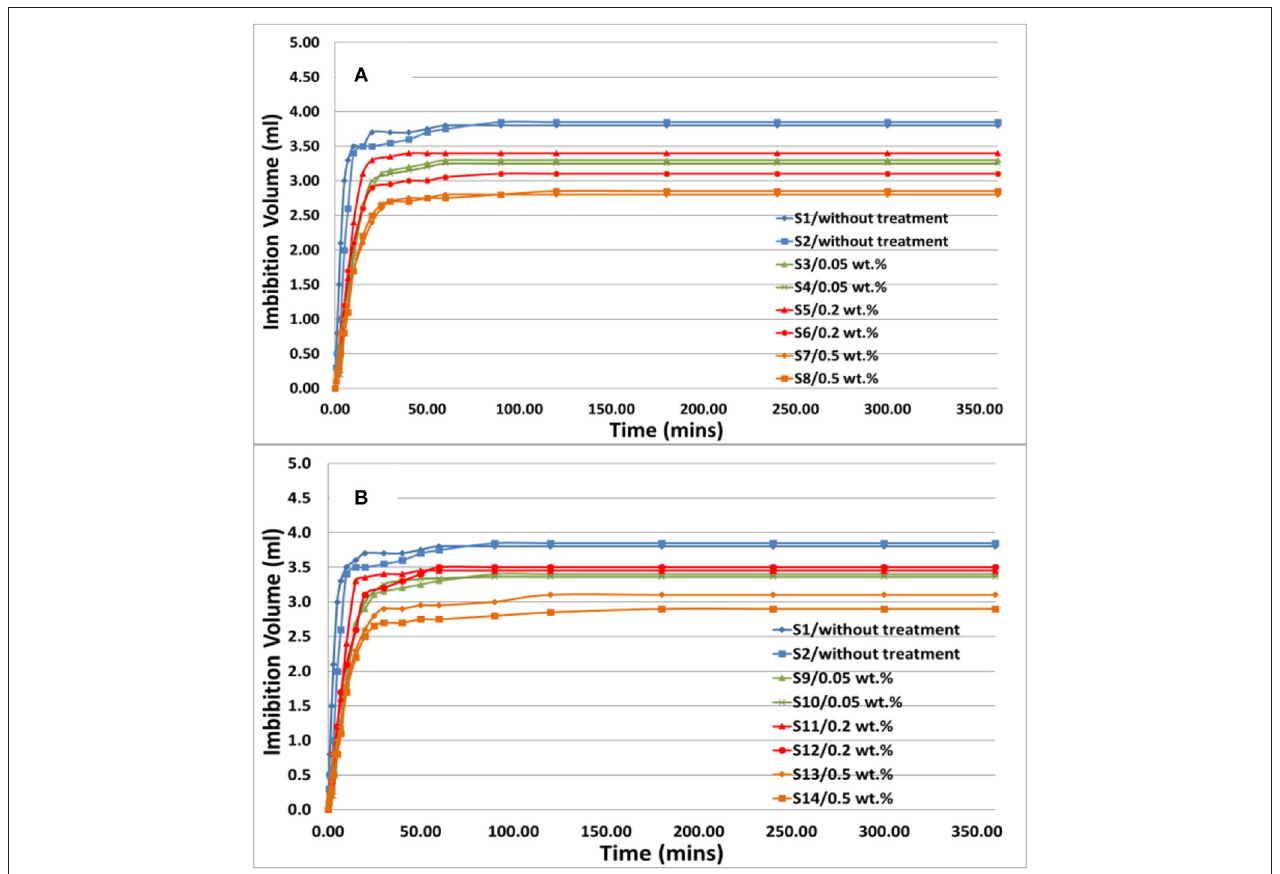
FIGURE 6 | Spontaneous imbibition curves: (A) core plugs treated with FNP; (B) core plugs treated with CNP.